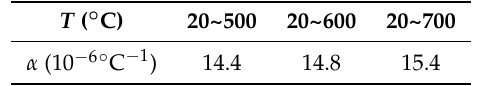
Table 5. Thermal expansion coefficients of GH4169 at different temperatures.